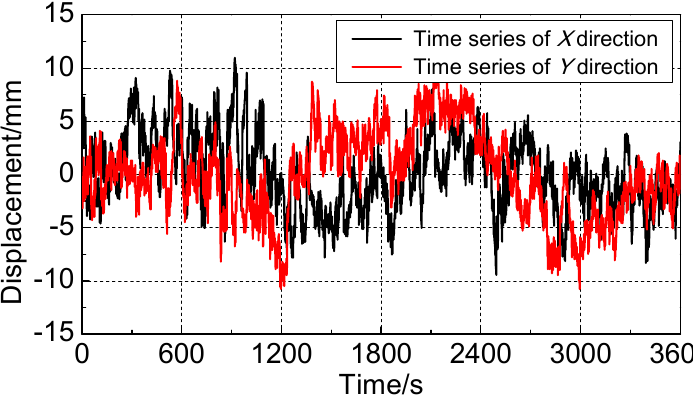
Figure 8. Time series diagram of the original observation data.